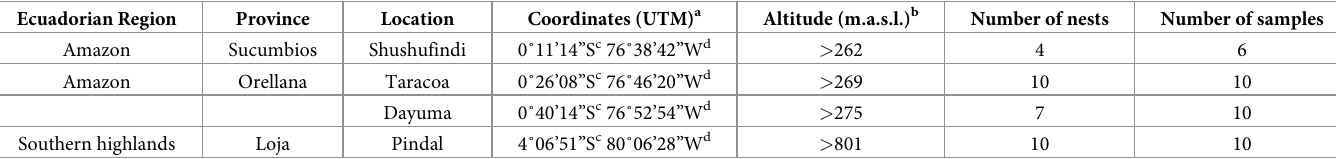
Pollen grains stored in pots out of stingless bee nests were collected during the transfer from natural nests to a technical nest (Fig 2) by taking the pollen directly from the top floor (storage place of stingless bee pollen pots) of the box or technical nest. The selection of one pollen pot by nest was random. Only sealed pots were sampled. Three to six grams of pollen were Table 1. Geographical location and number of the sampling